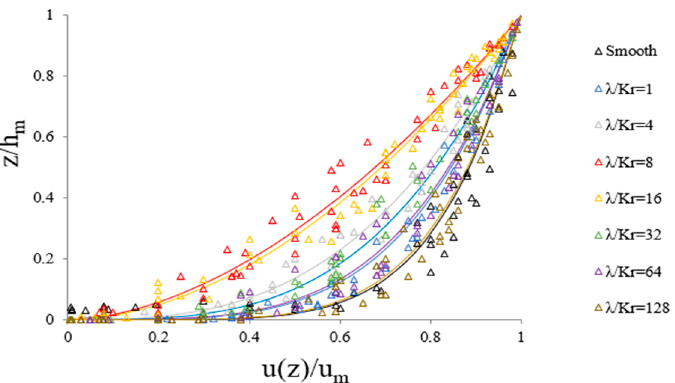
Figure 5. Dimensionless velocity profiles in the wall region at X = 4 m (Note: points are experimental data, and solid lines are fitted profiles).